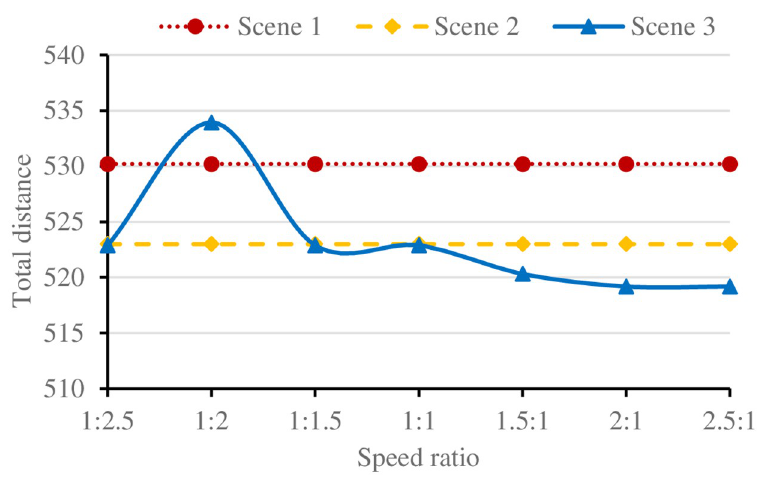
Fig 9. Results of three scenarios at different speed